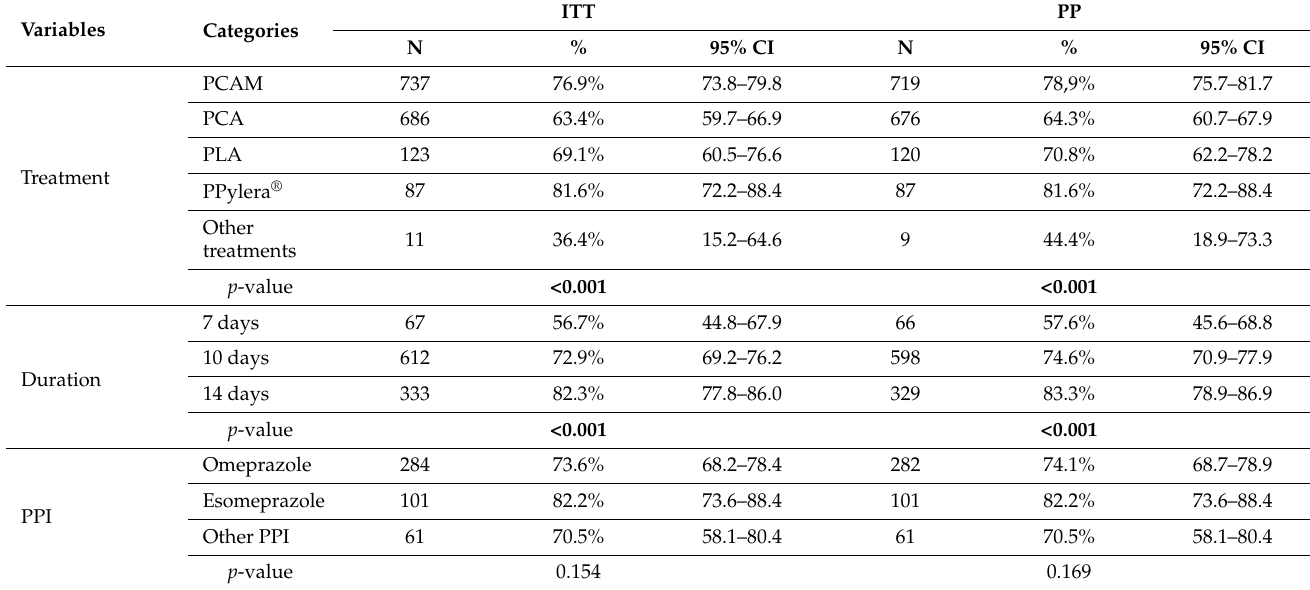
Table 2. Effectiveness of 1644 first-line treatments in non-penicillin-allergic patients: detailed analysis by